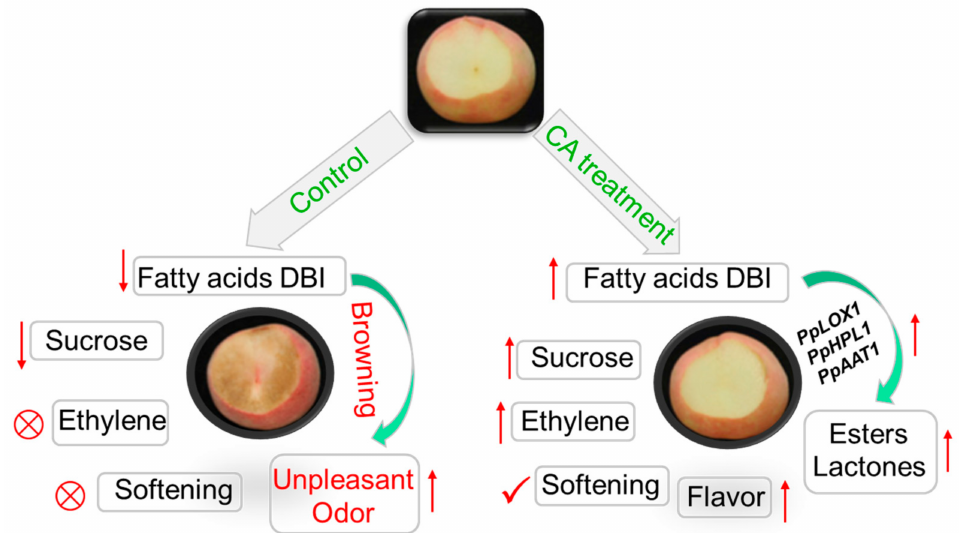
Figure 10. A proposed model of peach fruit biochemical and molecular change under cold storage plus subsequent